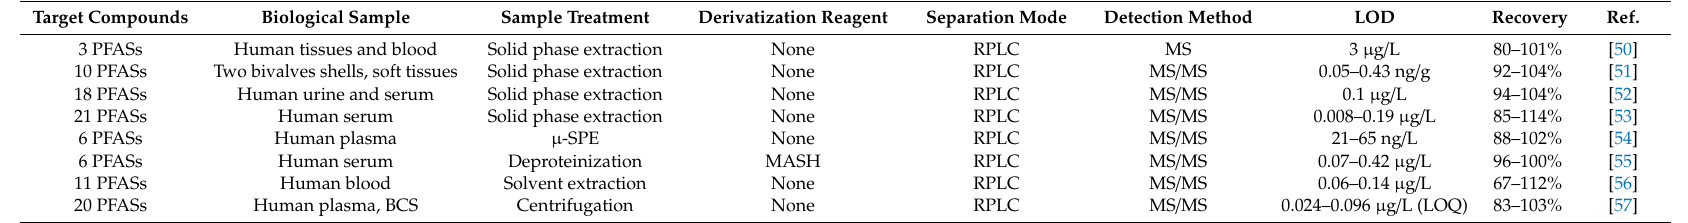
Table 4. Analytical methods for perfluorinated carboxylic acids (PFCAs) in biological samples.